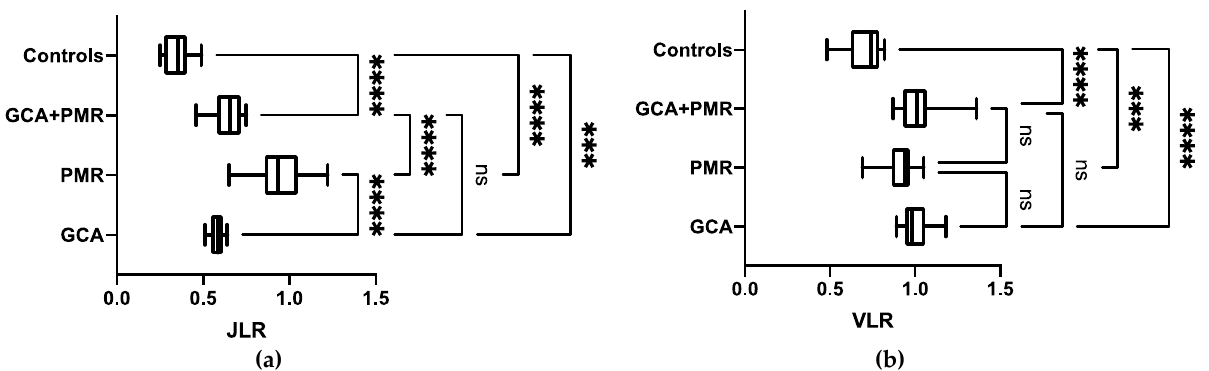
Figure 3. ( a ) The vessel wall ‐ to ‐ liver ratio (VLR) showed no significant differences between patients with final diagnosis of giant cell arteritis (GCA) + polymyalgia rheumatica (PMR) vs. PMR alone or GCA alone. Relative to the control group, significant differences were reached for all three subgroups. ( b ) The joint ‐ to ‐ liver ratio (JLR), however, was significantly increased in patients with PMR relative to GCA alone or GCA + PMR. Significant differences were also reached for all three subgroups when compared to controls. *** p = 0.0001; **** p < 0.0001; ns = not significant.